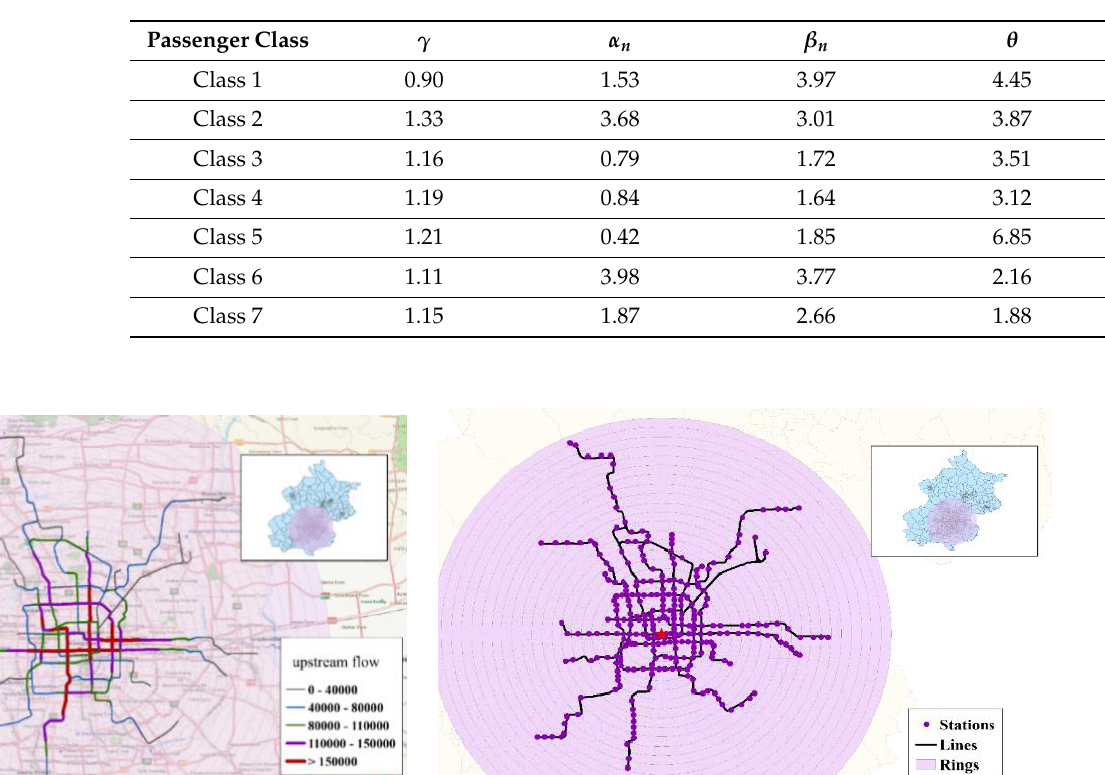
Figure 5. Fitting plots of station dimension for different years.